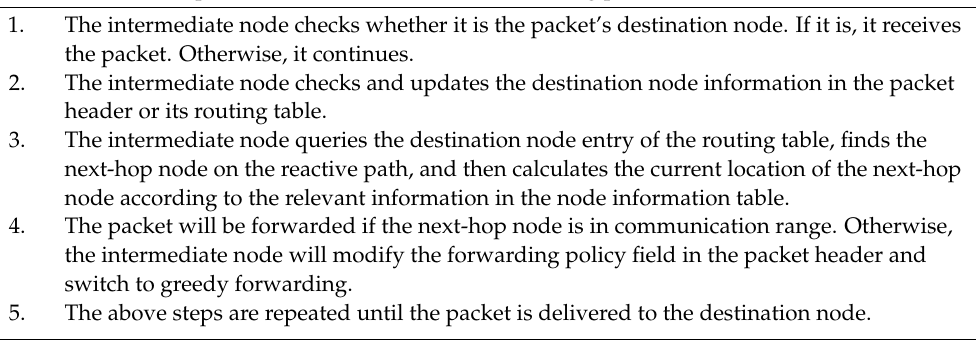
Algorithm 2: RGF protocol reactive mechanism forwarding packet